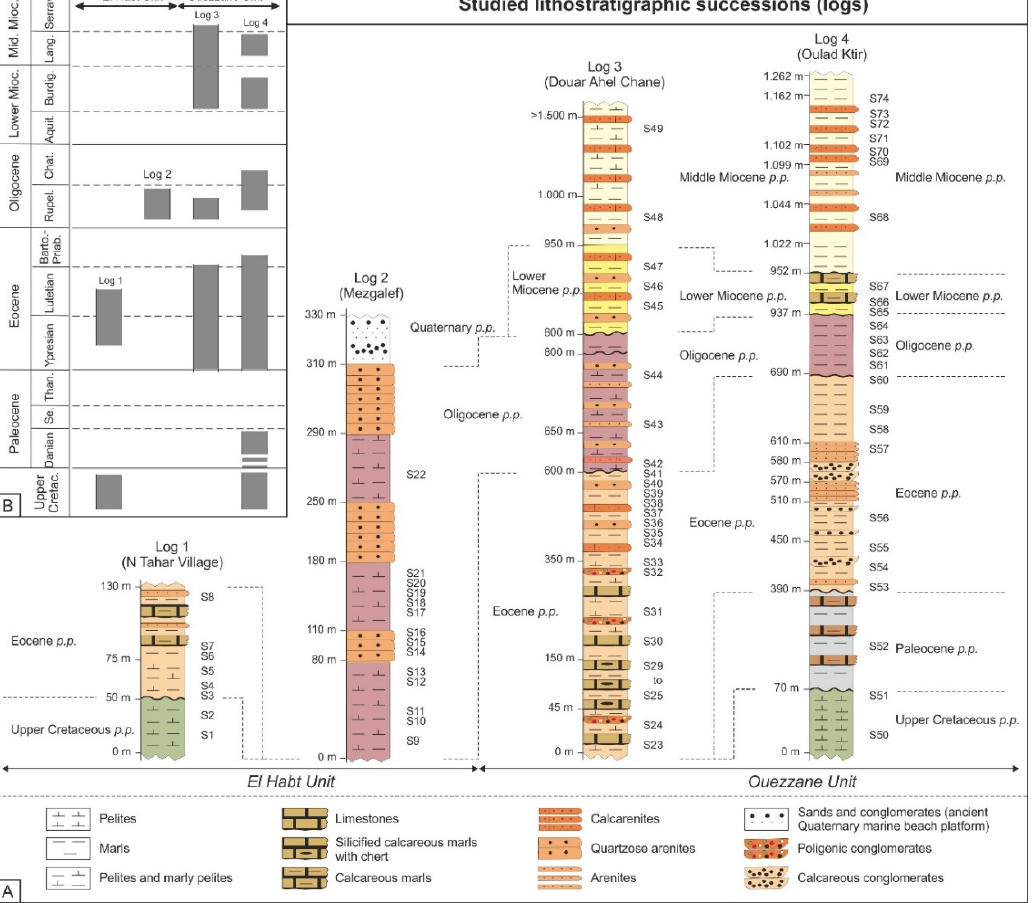
Table 1. Main field data (units, logs, localities, UTM coordinates, thickness, samples, boundary types, lithofacies and lithological associations) and laboratory results (ages, petrofacies and mineralogical associations). * Classification (NCE/CI/CE) according to Zuffa [68,69]; ** Classification (QFL) according to Dickinson [66]; Zuffa [68] and Ingersoll et al. [67].